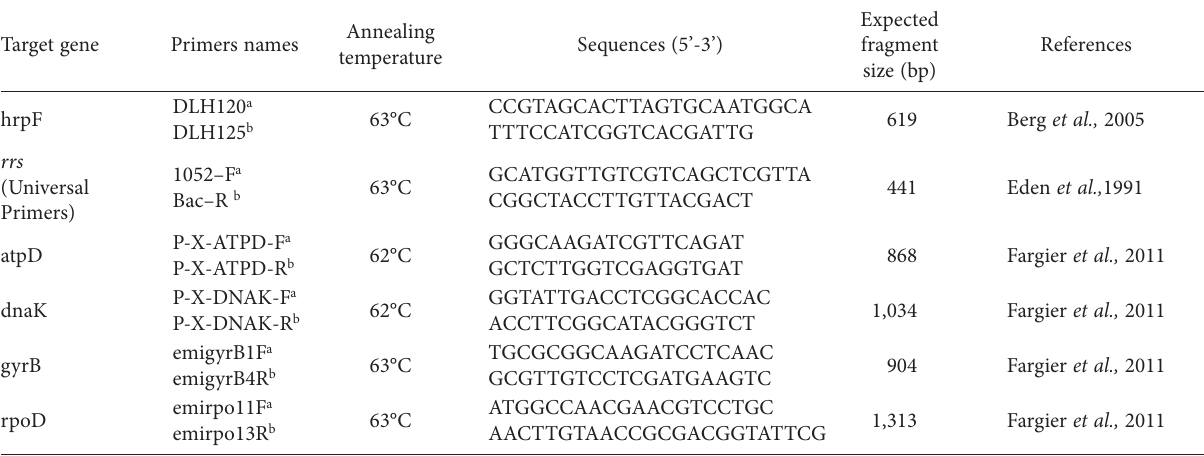
Table 2. Primers used for PCR amplification and sequencing of Algerian isolates of Xanthomonas campestris pv . campestris .